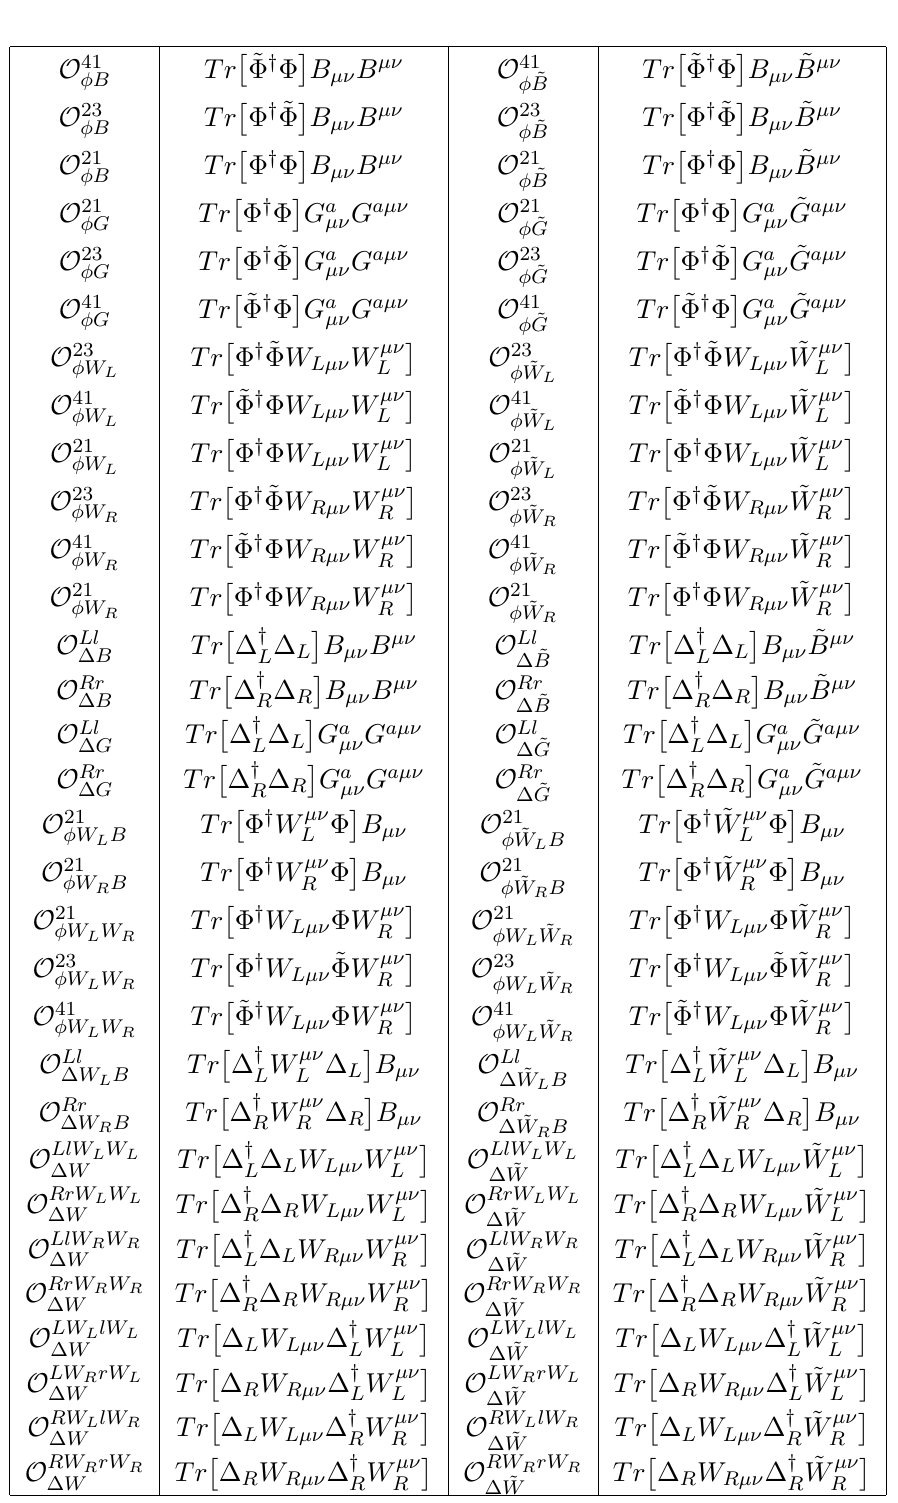
Table 25. MLRSM: (cid:30) 2 X 2 [62] class of operators. Note W (cid:22)(cid:23)